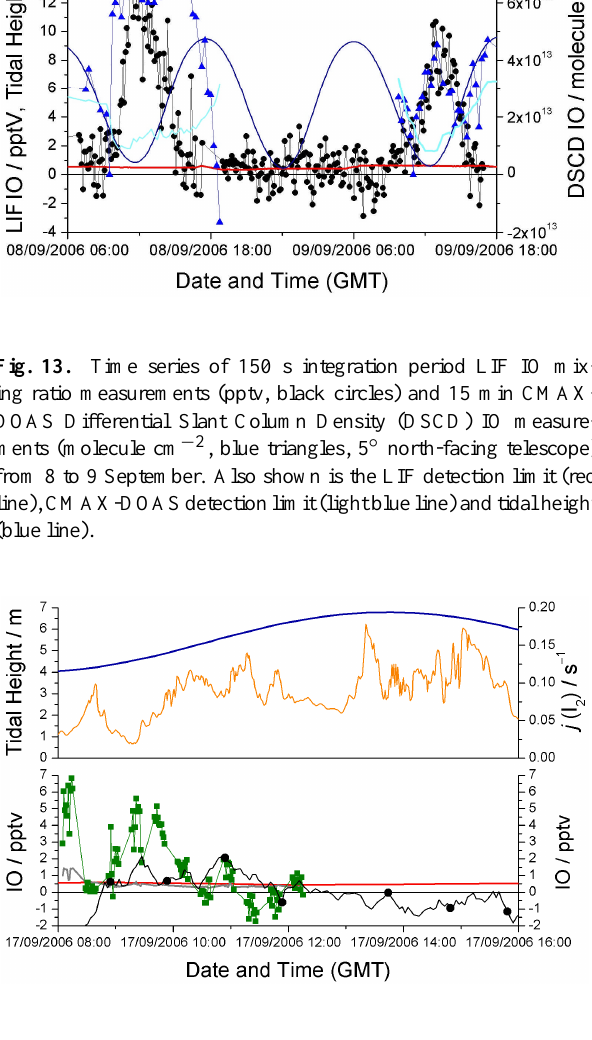
Fig.14. Top : Tidalheight(blueline)and j (I 2 )(orangeline). Bottom : Timeseriesof1000sintegrationperiodLIFIOmeasurements(black circles)and1minuteLP-DOASIOmeasurements(greensquares)on17thSeptember. AlsoshownistheLIFdetectionlimit(redline)and Fig. 14. Top: Tidal height (blue line) and j (I 2 ) (orange line). Bot- LP-DOASdetectionlimit(greyline). tom: Time series of 1000 s integration period LIF IO measure- ments (black circles) and 1 min LP-DOAS IO measurements (green squares) on 17 September. Also shown is the LIF detection limit (red line) and LP-DOAS detection limit (grey